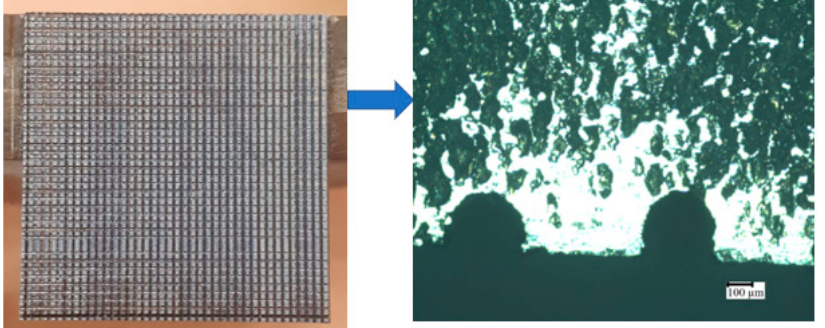
Figure 1. Surface modification of titanium sample with ‘U’ shape using electrical discharge ma- chine (EDM). chine